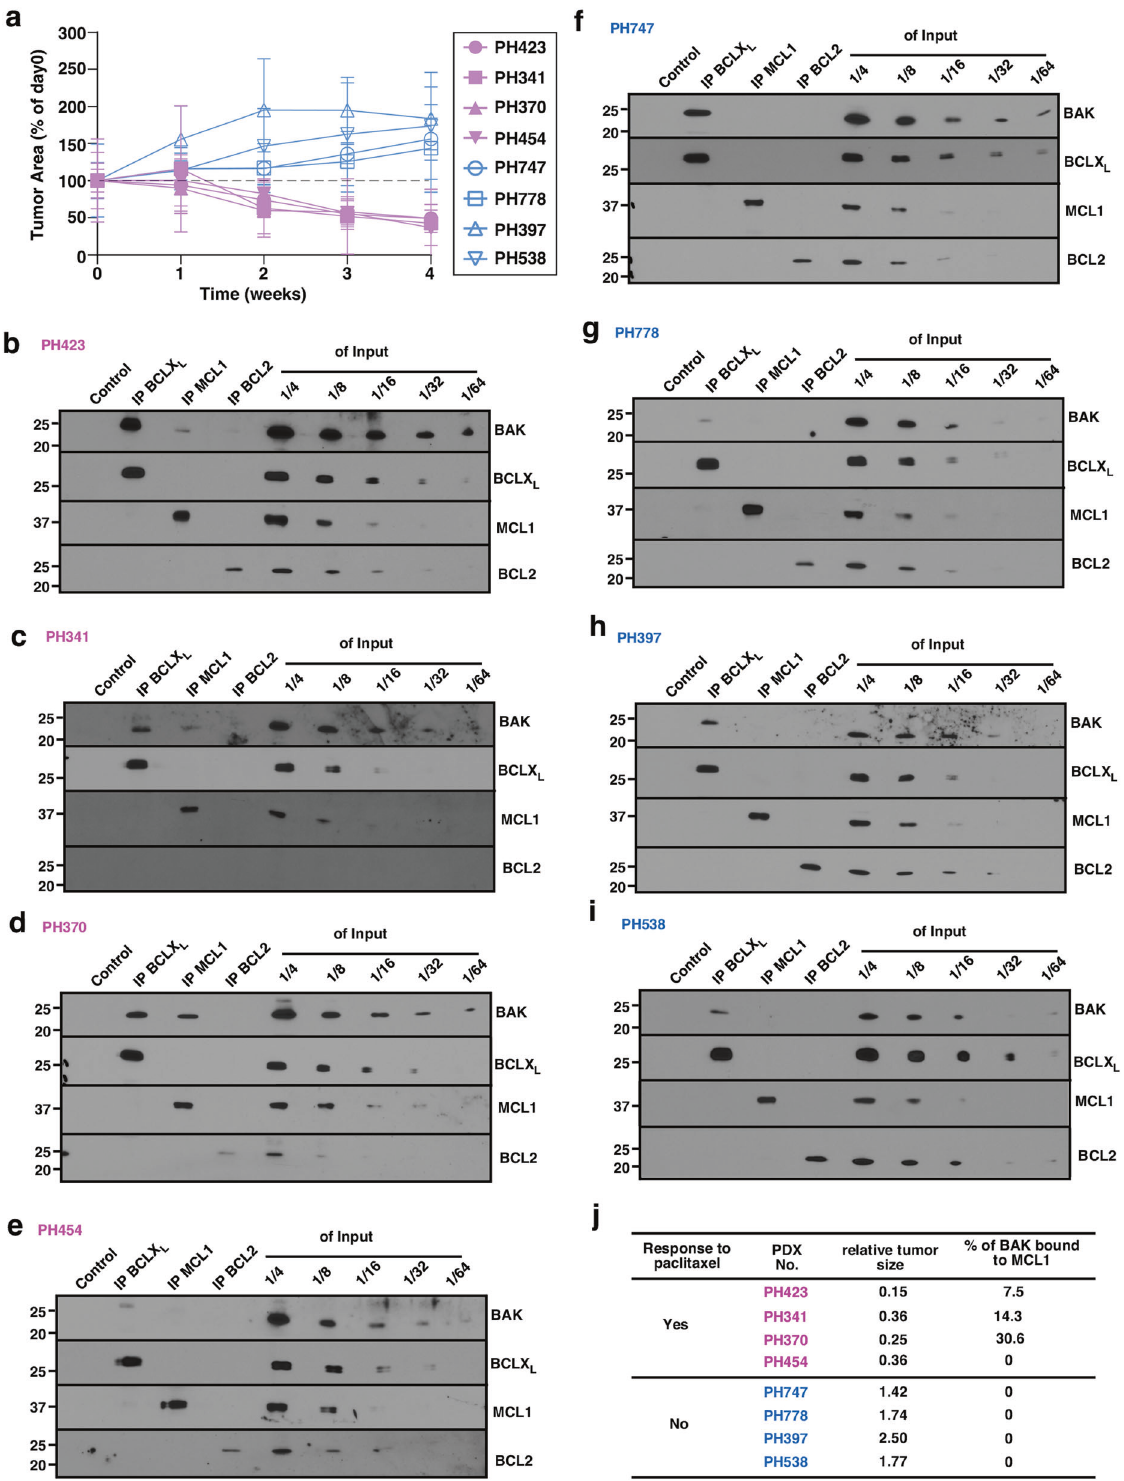
Fig. 3 Pre-formed BAK/MCL1 complexes predict paclitaxel sensitivity in PDX models. a Four PDX models (PH423, PH341, PH370, and PH454) showed tumor reduction after paclitaxel treatments and four PDX models (PH747, PH778, PH397, and PH538) did not show tumor reduction after paclitaxel treatments. b – i CHAPS lysates of PDX samples PH423 ( b ), PH341 ( c ), PH370 ( d ), PH454 ( e ), PH747 ( f ), PH778 ( g ), PH397 ( h ), and PH538 ( i ) were immunoprecipitated (IP) with antibodies to BCLX L , MCL1, or BCL2, and compared with serial dilutions of the input. Pull- downs with protein G beads only served as a negative control. j Relative tumor size as assessed by transabdominal ultrasound after treatment and % BAK bound to MCL1 are summarized for PDX samples in both the paclitaxel responsive group (purple numbers) and paclitaxel unresponsive group (blue numbers). The relative tumor size after treatment was calculated by (tumor area after treatment)/(tumor area before treatment). Relative tumor size ≤ 0.5 was de fi ned as responsive and relative tumor size >1.0 was de fi ned as